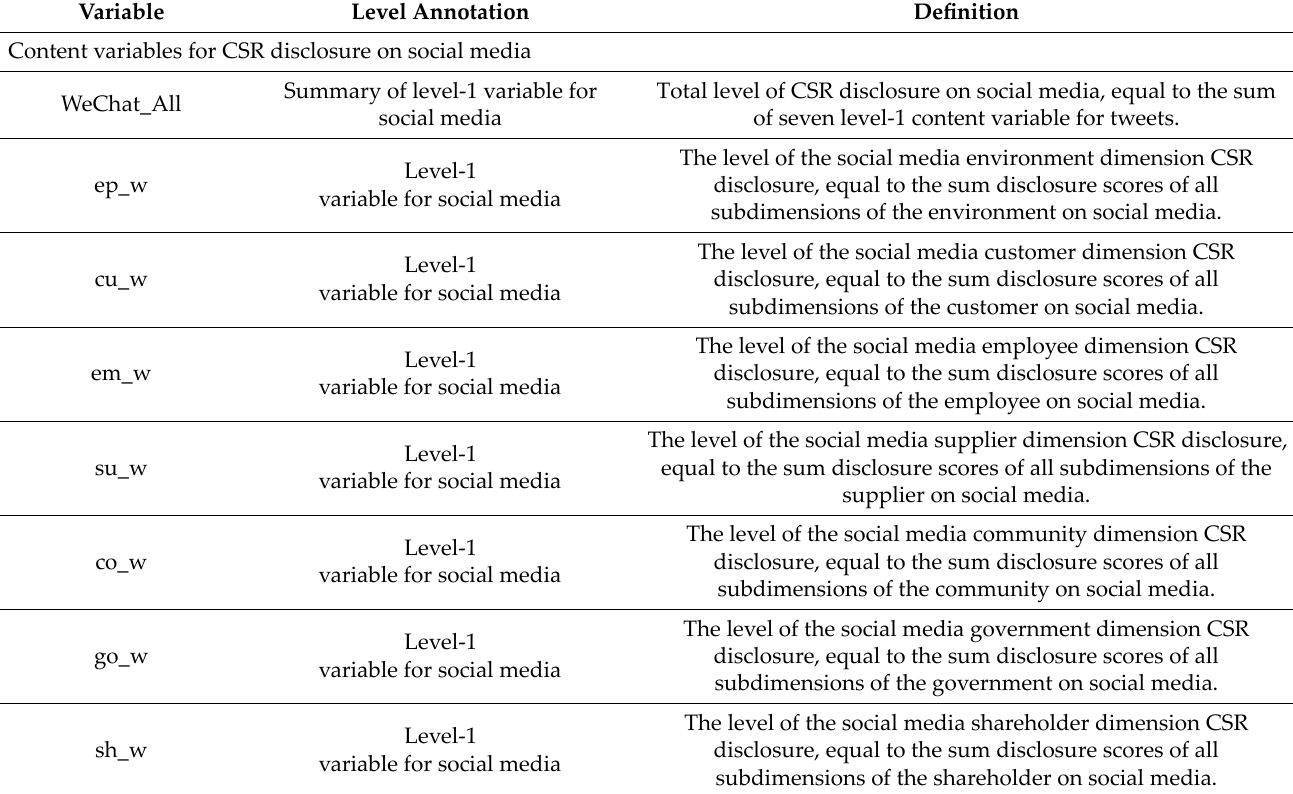
Table 1. Variable